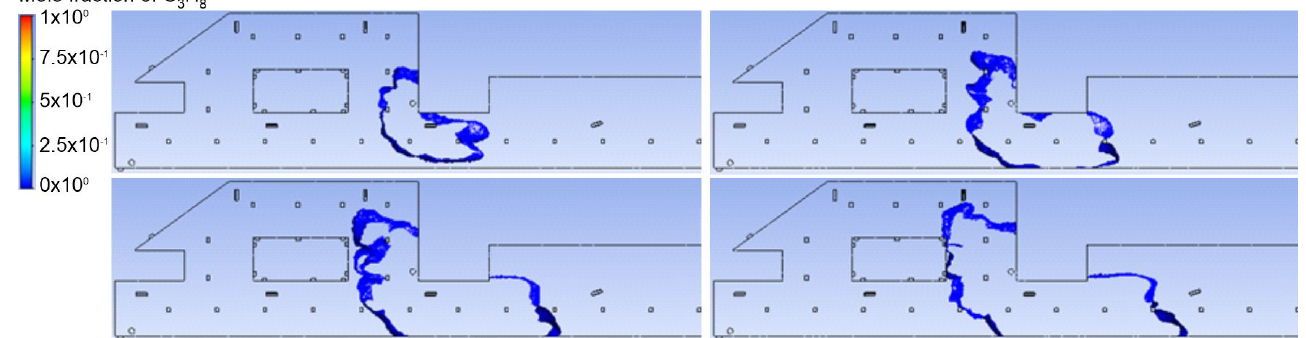
Figure 10. Trace amount of LPG near the end of dispersion for B source.